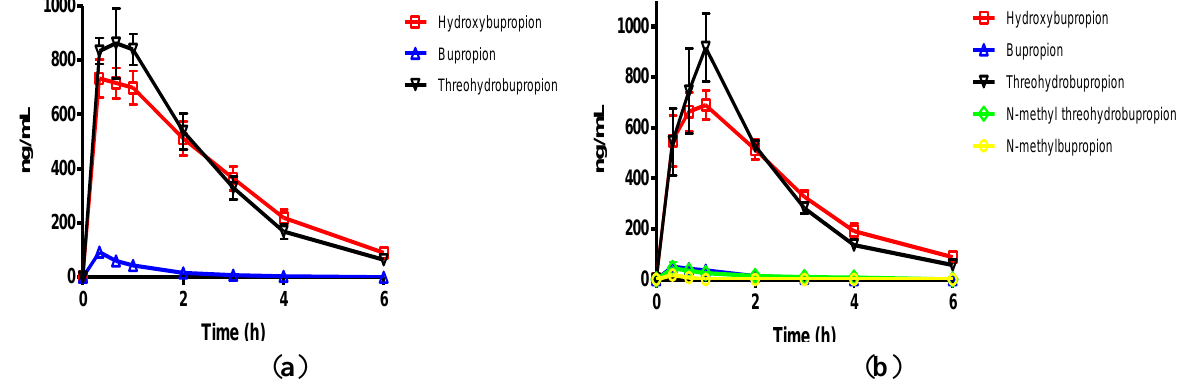
Figure 6. ( a ) Mean brain concentrations of bupropion and metabolites 20 min after dosing 40 mg/Kg bupropion in guinea pig by oral gavage ( n = 5). Concentrations are expressed in terms of ng of compound per g of brain tissue; ( b ) Mean brain concentrations of N -methyl- bupropion and metabolites 20 min after dosing 42 mg/Kg N -methylbupropion in guinea pig by oral gavage ( n = 5). Concentrations are expressed in terms of ng of compound per g of brain